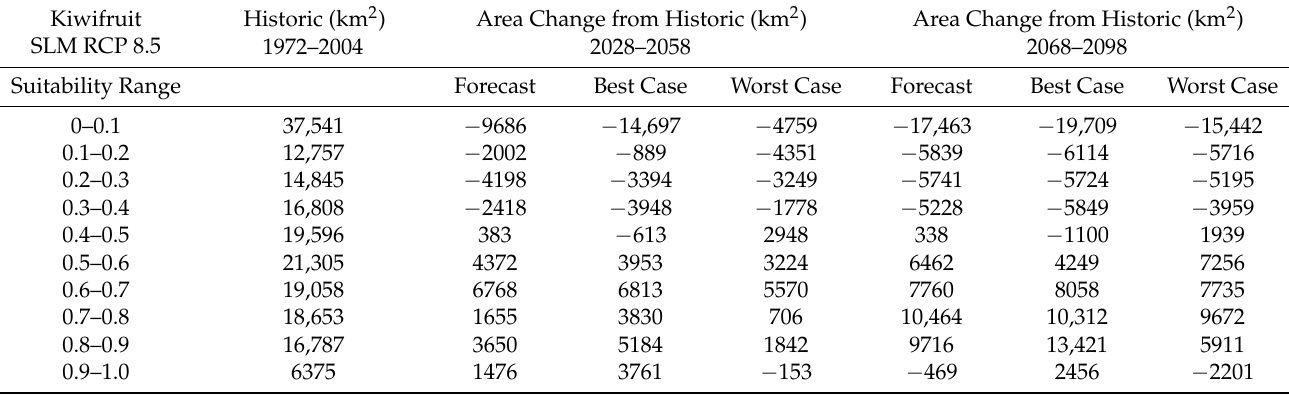
Table A5. Kiwifruit: land area in the historic period falling into different cultivation suitability ranges, forecast change for the mid- and late-century under RCP 8.5 and best and worst